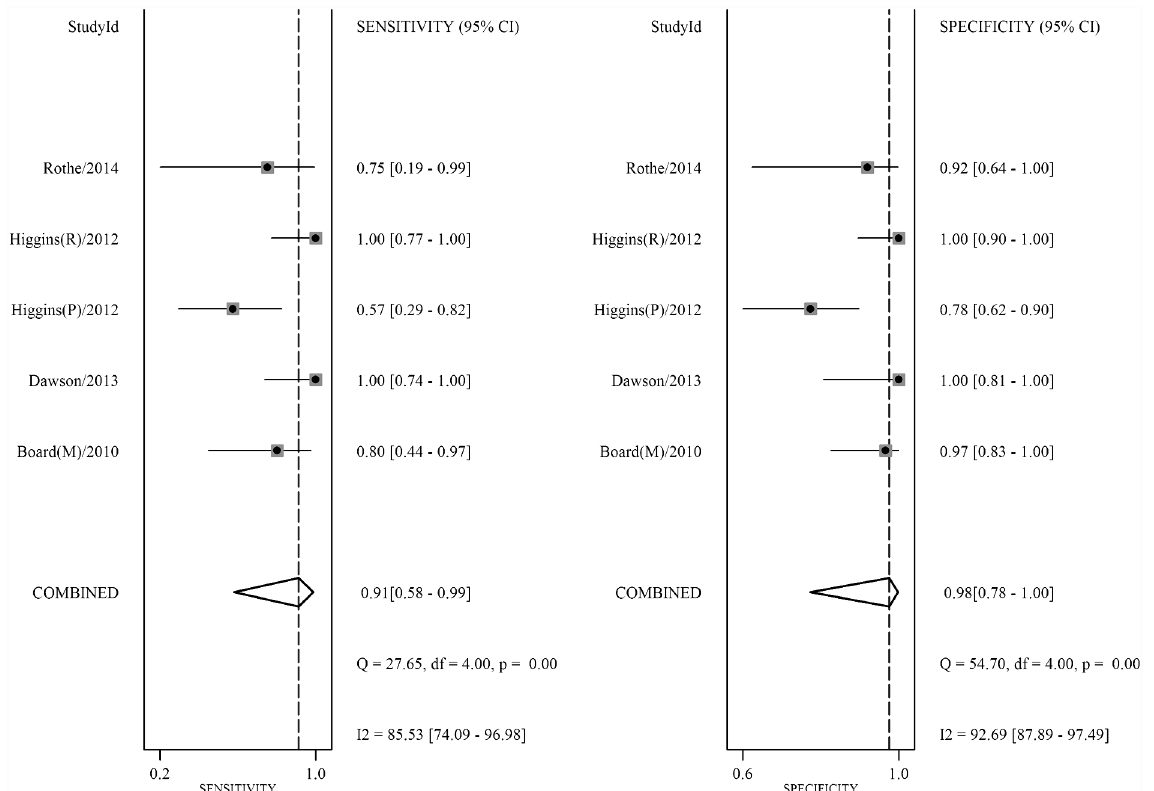
Fig 4. Forest plot showing study-specific and overall sensitivities and specificities with corresponding heterogeneity evaluation of MBC